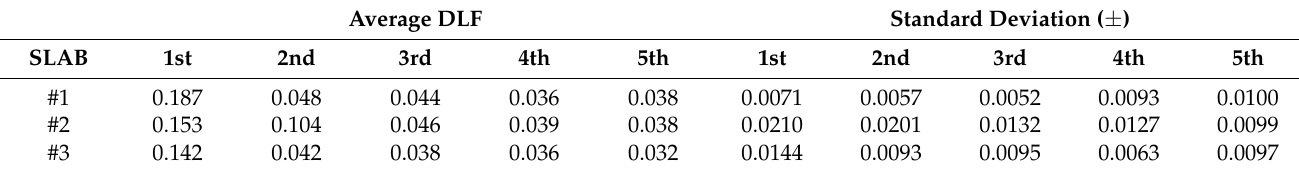
Table 6. Average trend and standard deviation of DLF values of normal walk ( f p = 1.5 Hz), as obtained from experimental records for longitudinal force component on different substructures (with 8 walking records for SLAB#1, 10 for #2, and 9 for #3 and a single adult pedestrian volunteer). Average DLF Standard Deviation ( ± ) 2nd 3rd 4th 5th 1st 5th